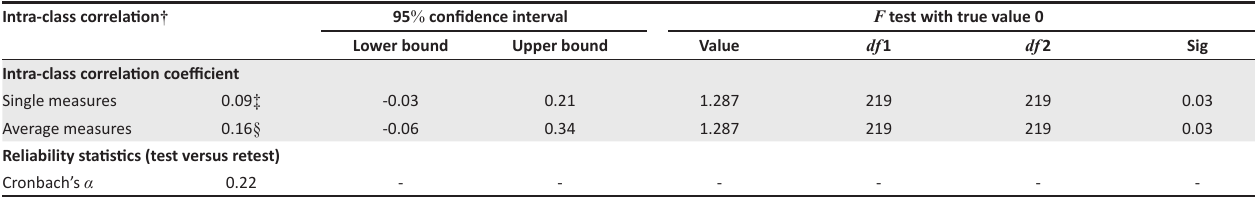
TABLE 3b: Cronbach’s alpha and intra-class correlation coefficient of personal evaluation of transitions in treatment. Intra-class correlation